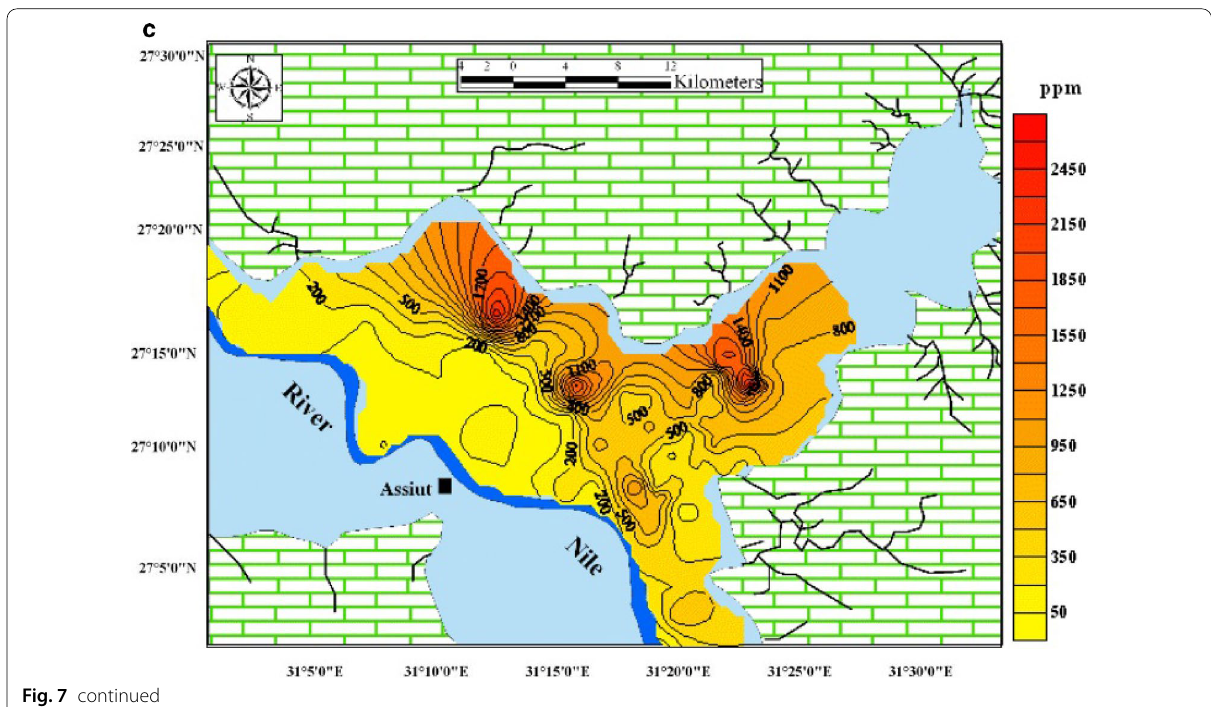
Table 5 Results of the chemical analysis of the trace elements in some groundwater samples Well No. Trace elements Well